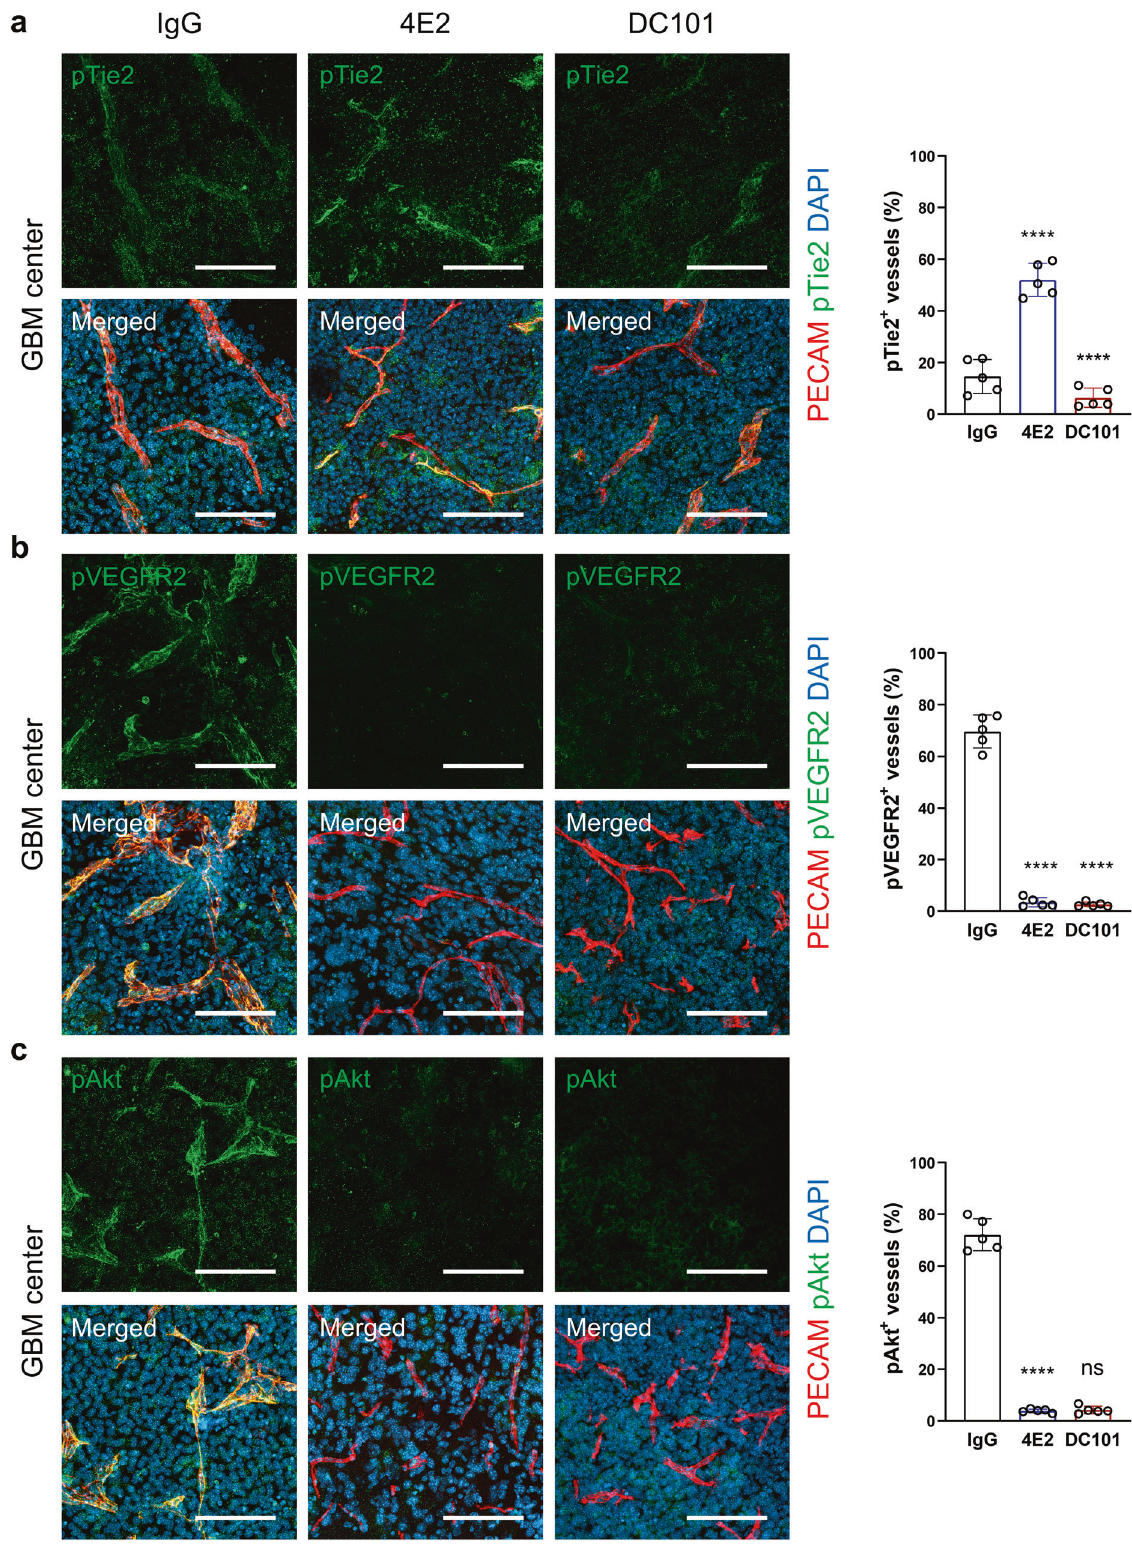
Fig. 7 Tie2 activation reduces the level of phosphorylated VEGFR2 in GBM vessels. a Increase in phospho-Tie2 in GBM vessels by 4E2 treatment, with quanti fi cation ( n = 5 per group). b Decrease in phospho-VEGFR2 in GBM vessels by 4E2 or DC101 treatment, with quanti fi cation ( n = 5 per group). c Decrease in phospho-Akt in GBM vessels by 4E2 or DC101 treatment, with quanti fi cation ( n = 5 per group). Scale bars: 100 µm ( a – c ). ns not signi fi cant; ****, P < 0.0001 vs.